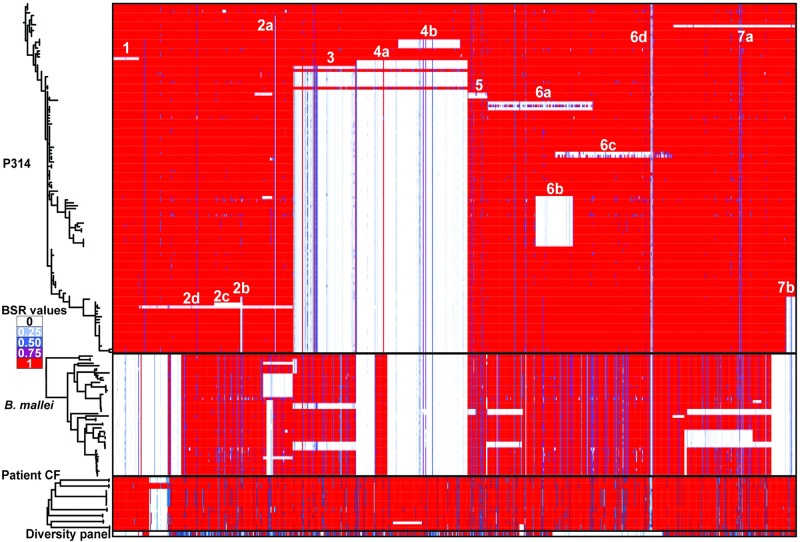
Convergent gene deletions among long-term carriage and non-host-adapted genomes.Genes from the 7 deleted regions (Fig 2) found among P314 isolates are mapped against 51 B. mallei genomes, chronic B. pseudomallei genomes from 7 CF patients, and a diverse panel of acute/environmental B. pseudomallei genomes. Parts of each of the seven regions deleted among P314 genomes were also deleted in B. mallei genomes. Portions of three of the seven regions were also deleted in some genomes associated with long-term CF infections, however two of these deletions were evident in both the initial and later isolates, suggesting that their absence is not necessarily linked to host adaptation. Indeed, these genes are also absent in the diverse panel of non-host-adapted (acute and environmental) genomes. Conversely, part of region 4b was deleted over the course of a CF infection and among all B. mallei. None of the genes from this region were deleted in any of the genomes from the acute and environmental panel, suggesting that their deletion may be a specific adaptation to long-term carriage. Deletions in the 6d region correspond to the NRPS gene (Fig 4) and are also observed in other genomes from these panels. Putative deletions seen among P314 genomes were assumed to be due to fragmented assemblies if they could not be verified with read mapping (Fig 2) and were thus not assigned a number/letter.